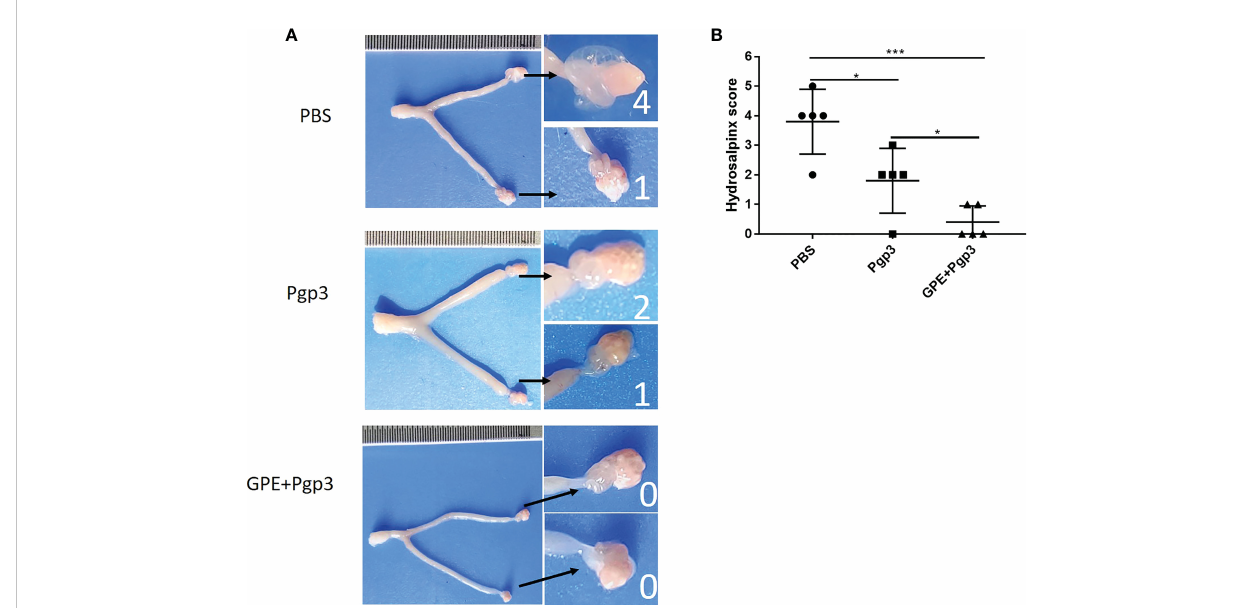
FIGURE 11 Histopathological changes and hydrosalpinx in genital tract post (C) muradirum challenging. (A) Hydrosalpinx of a representative mouse. The areas covering the oviduct portions were magni fi ed and are shown on the right side of the corresponding images of whole genital tracts. Hydrosalpinx indicated by black arrows and hydrosalpinx severity scores indicated by white numbers; (B) Hydrosalpinx score of each group of mice, with the two sides scores added together to obtain the fi nal score of one mouse. Severity of hydrosalpinx listed along the Y-axis and the three different vaccination groups listed along the X-axis. N = 5.).